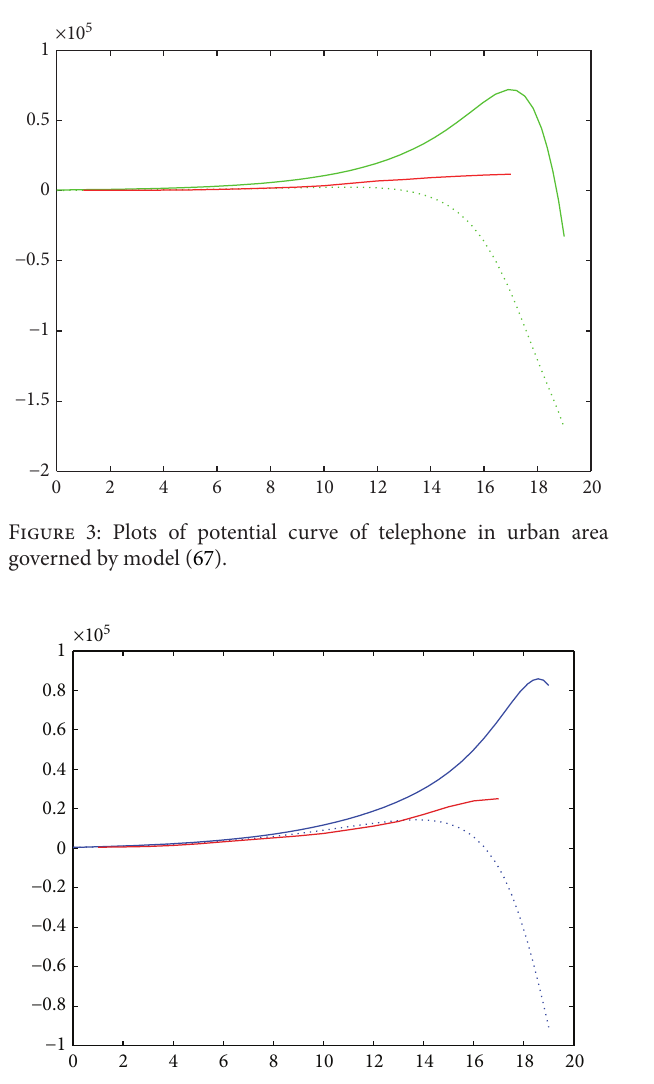
Figure 6: Plots of potential curve of telephone in urban area and rural area governed by model (68) (the control error rate is 50%).